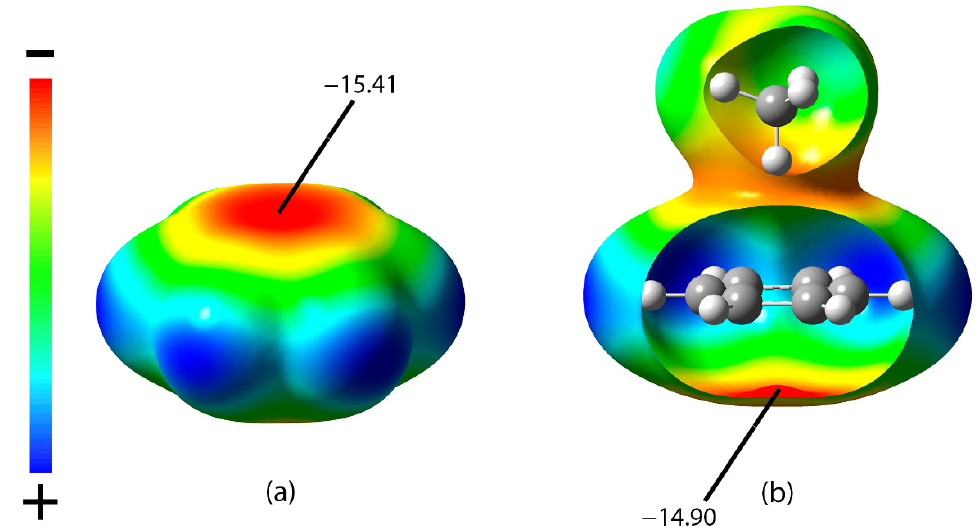
Figure 4. Electrostatic potential (ESP) on the 0.001 a.u. electron density isosurface of benzene ( a ), and complex 1 ( b ). The ESP energy values indicated are in kcal/mol. Carbon and hydrogen atoms are indicated in grey and white color, respectively.